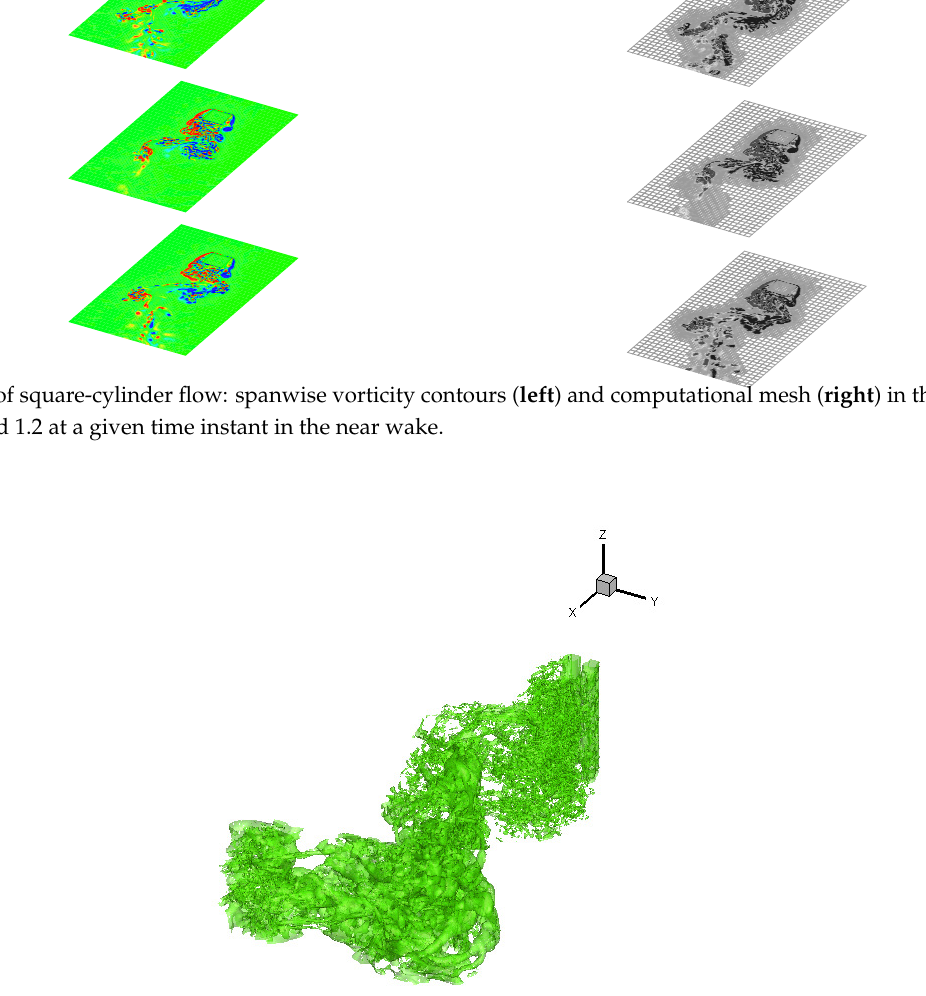
Figure 4. WA-LES of square-cylinder flow: iso-surfaces of (cid:101) = 0.12 in the near